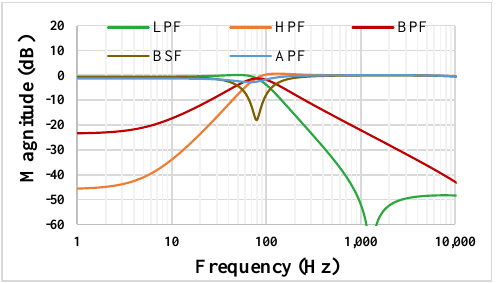
Figure 12. The magnitude characteristics of the universal filter. The BPF was tested by applying a sine wave signal V in = 100 mV pp @ 81.47 Hz. The waveforms of the input and output voltages are shown in Figure 13a. The spectrum of the output signal is shown in Figure 13b, where the total harmonic distortion (THD) of the BPF output is 0.5%.